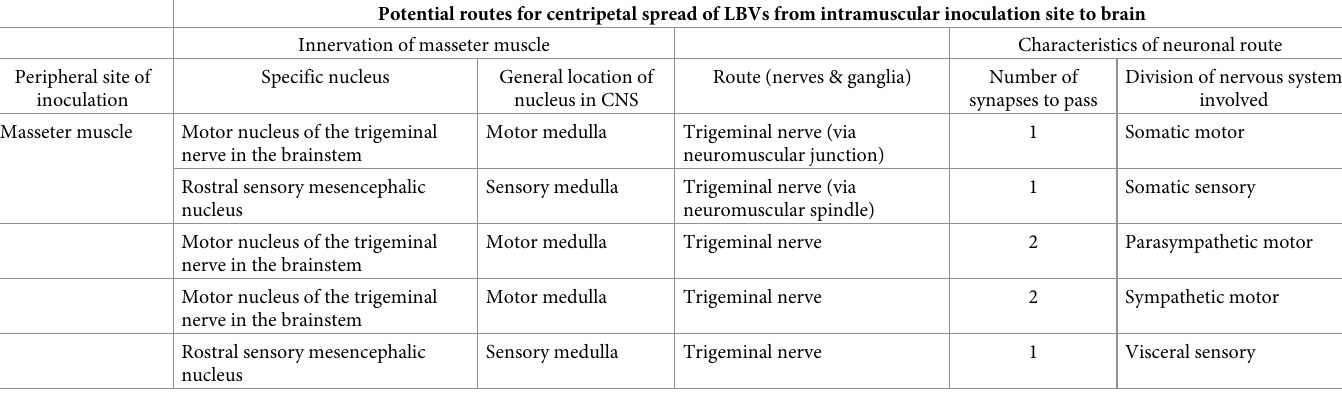
Table 5. Possible neuronal routes for Lagos bat virus to spread from the intramuscular inoculation site to the brain (centripetal spread). Potential routes for centripetal spread of LBVs from intramuscular inoculation site to